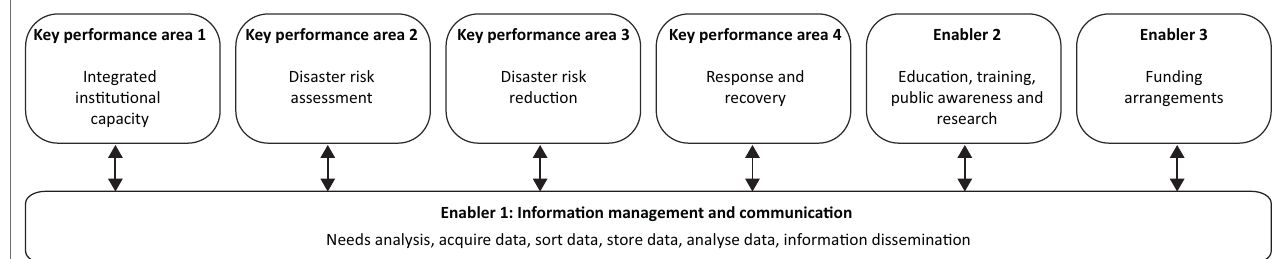
Key performance area